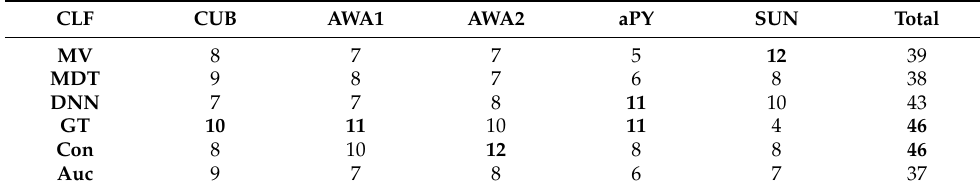
Table 11. Meta-Classifier Combined